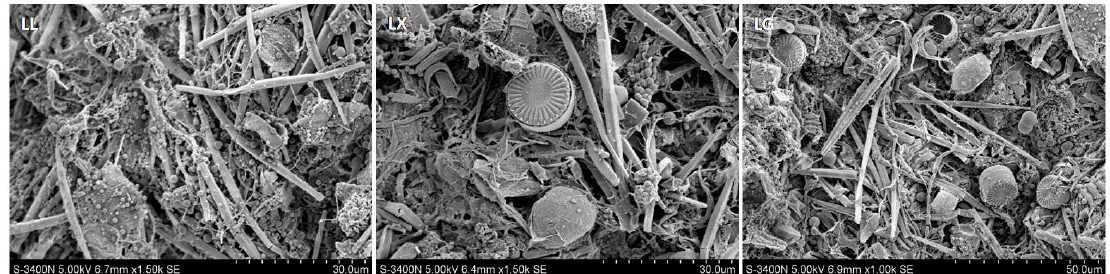
Figure 1. Scanning electron microscopy (SEM) images of water microbial community composition associated with Lianhu lake (LL), Xingqing lake (LX), and Geming lake (LG) in Xi’an City, Shaanxi Province, China.